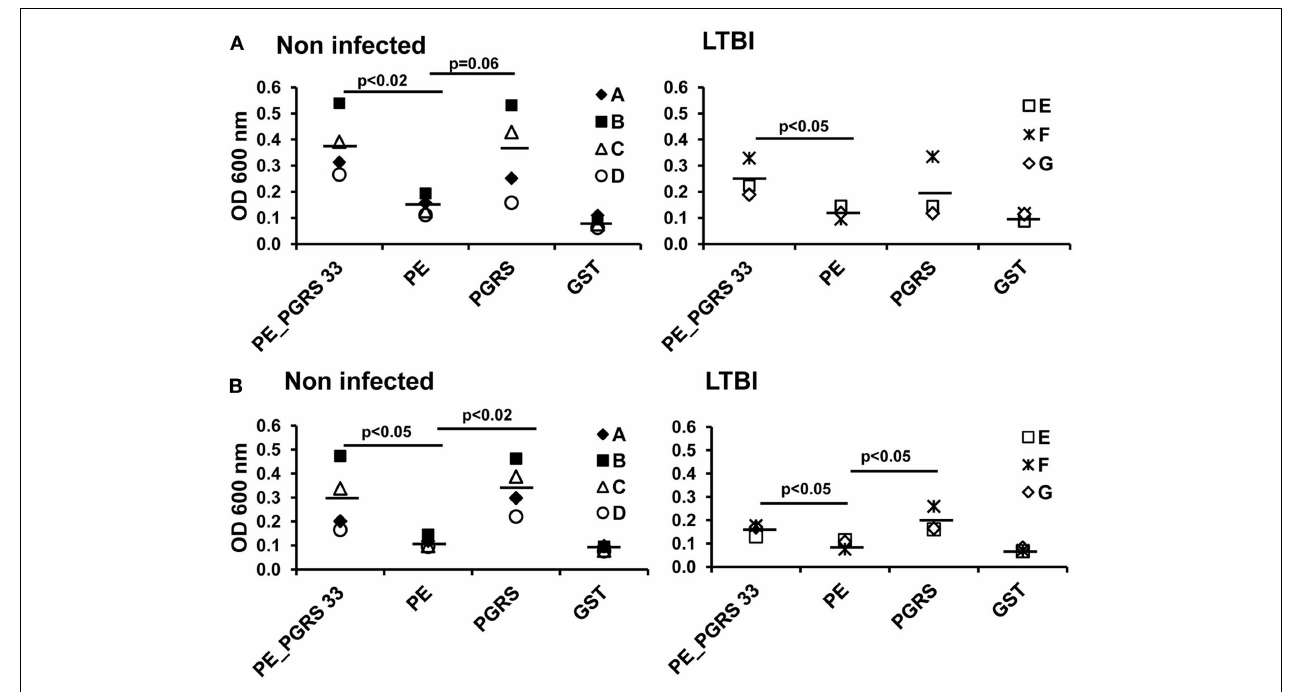
protein GST. Antigen-specific IgG (A) and IgG1 (B) were evaluated by ELISA. Letters in legend represent each individual tested and symbols correspond to OD readings. Mean values are showed as horizontal bars.